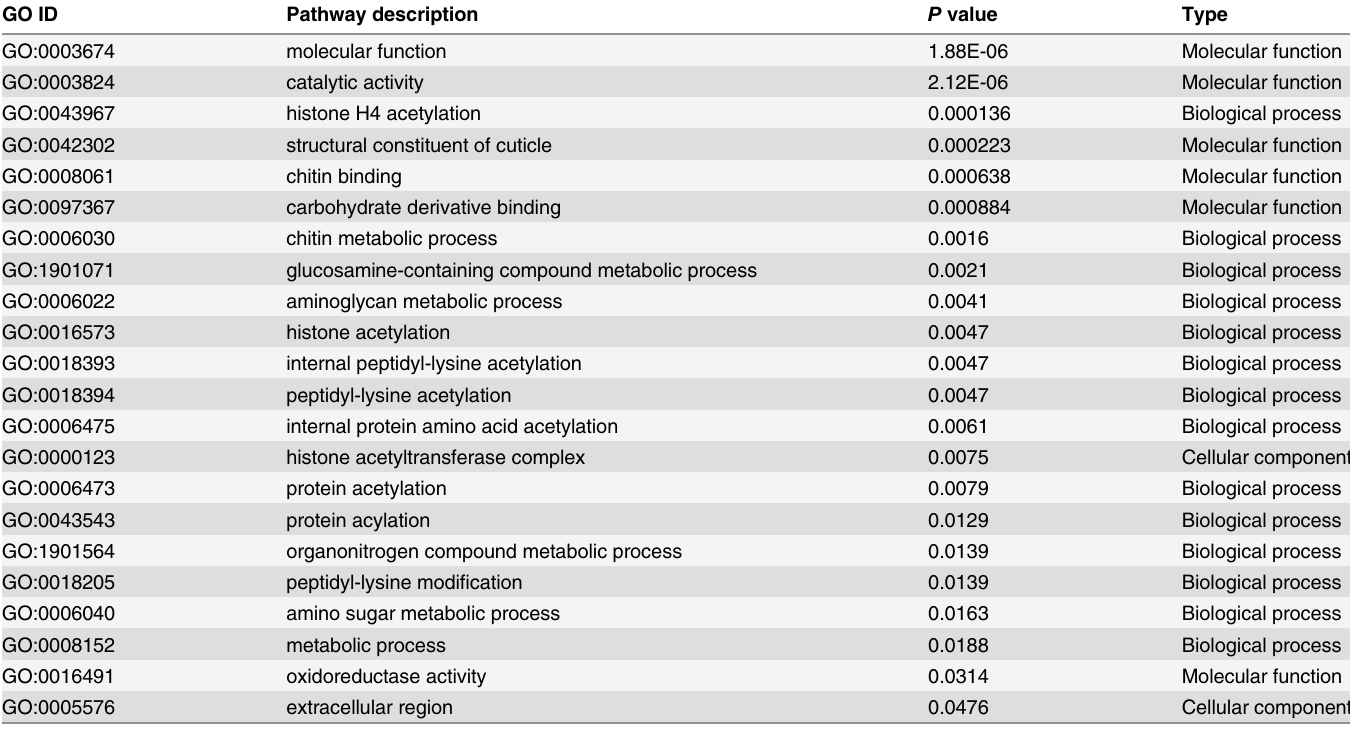
Table 5. Significantly changed GO pathways of L . vannamei between the two